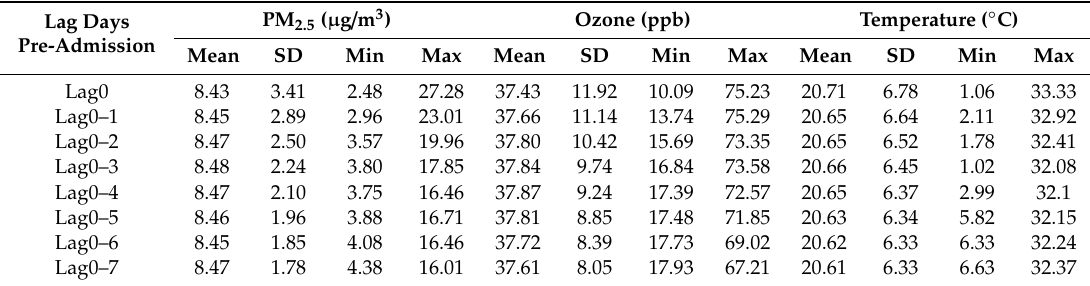
Table 2. Summary statistics of daily average air pollutant concentrations and temperatures from Lag0 to Lag0–7.